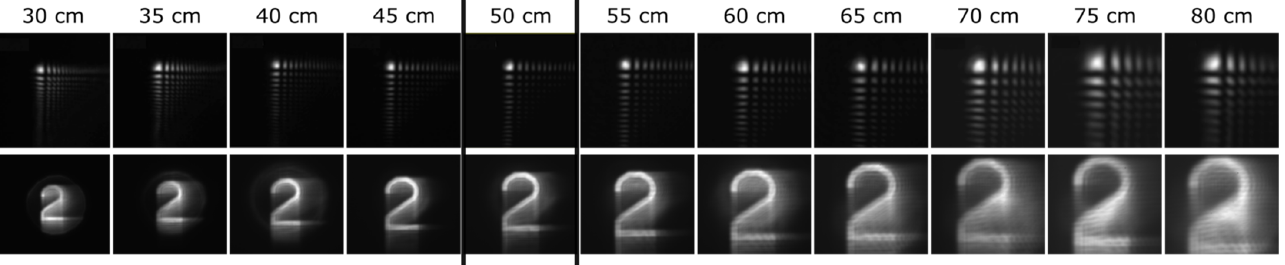
Figure 7. Experimental results of the PSFs (top) and the images of the extended object (bottom) for the combined APM + FL imaging system with the optimized value α = 100/ π along the z’-image plane range (rectangle in the in-focus position) obtained with the optical setup depicted in Figure 1. The pupil size was L = 8.64 mm.